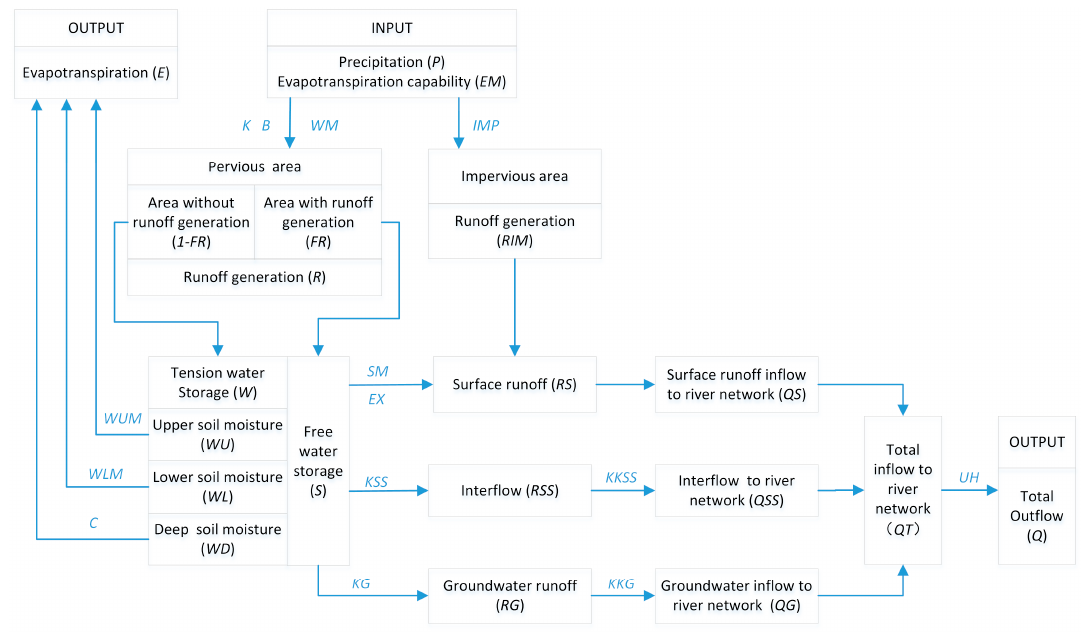
Figure 1. The framework of the Xinanjing model (XAJ) [37].